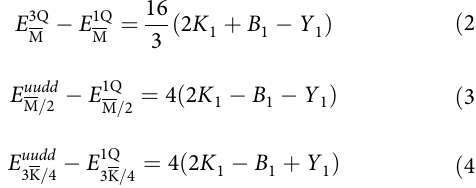
Fig. 1d) and the magnetic moments of an atom at lattice site R i is magnetic moment M . Fig. 1e shows the energy dispersion E ( q ) of spin spirals without SOC along two high symmetry directions obtained via DFT for an fcc-Pd/Fe bilayer on the Rh(111) surface 34 (Fig. 1a). At the high symmetry points of the 2DBZ, we fi nd well-known magnetic states: the ferromagnetic (FM) state at the Γ point, the row-wise antiferromagnetic (AFM) state at the M point and the Néel state with angles of 120° between adjacent magnetic moments at the K point. states (Fig. 1e). Along both high symmetry directions, the 90° spin spirals (Fig. 1c) are found at q ¼ ð 1 = 2 Þ Γ M and at q ¼ ð 3 = 4 Þ Γ K (Fig. 1d). The total energy of homogeneous spin spirals without SOC is fi tted to functions obtained by expressing the Heisenberg model ( fi rst term of Eq. (1)) in reciprocal space to extract the exchange interaction parameters up to 11th nearest neighbors (Supplementary Table 1).